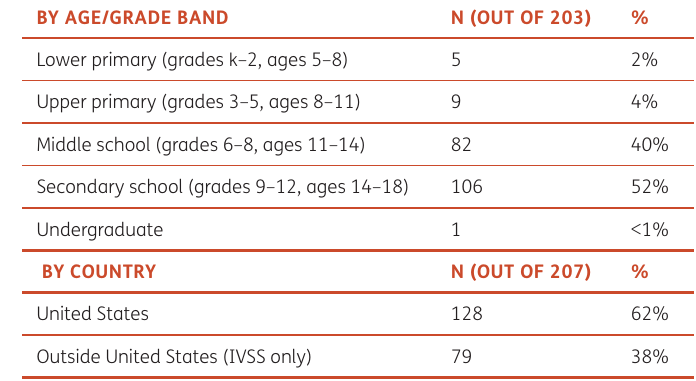
Table 1 Grade band and country of students submitting